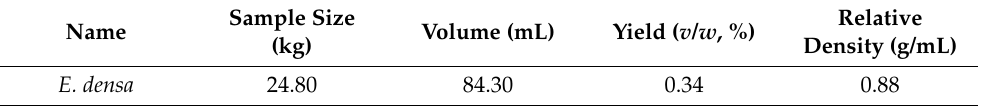
Table 2. EO yield of the aerial parts of E. densa